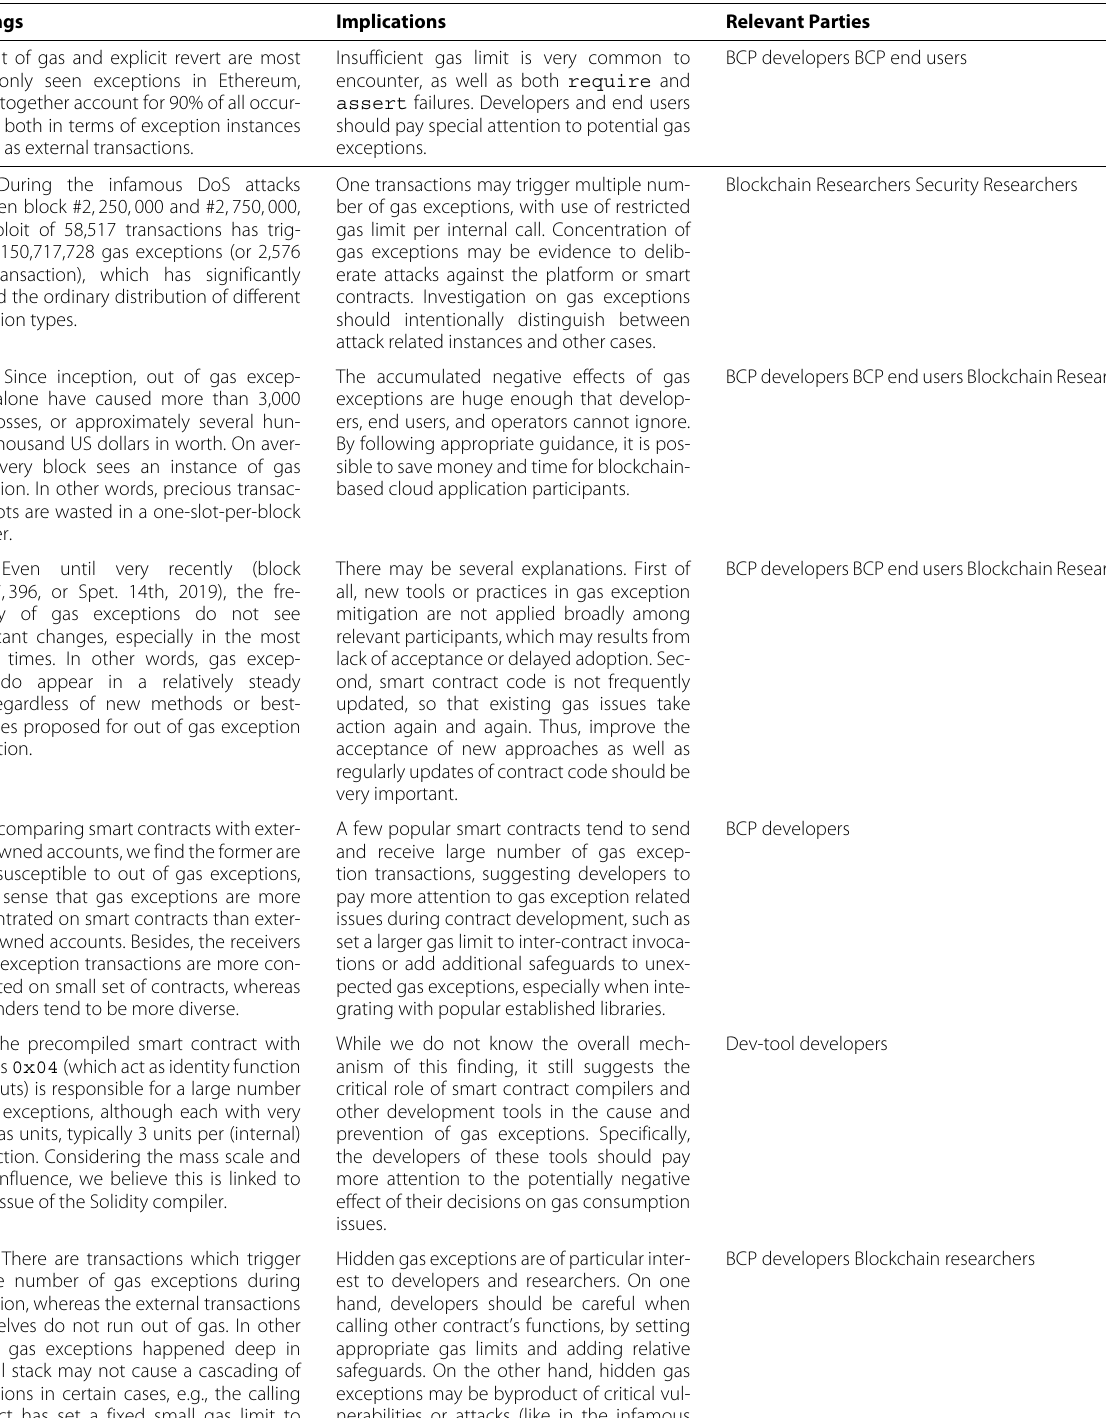
Table 9 Summary of important findings and implications